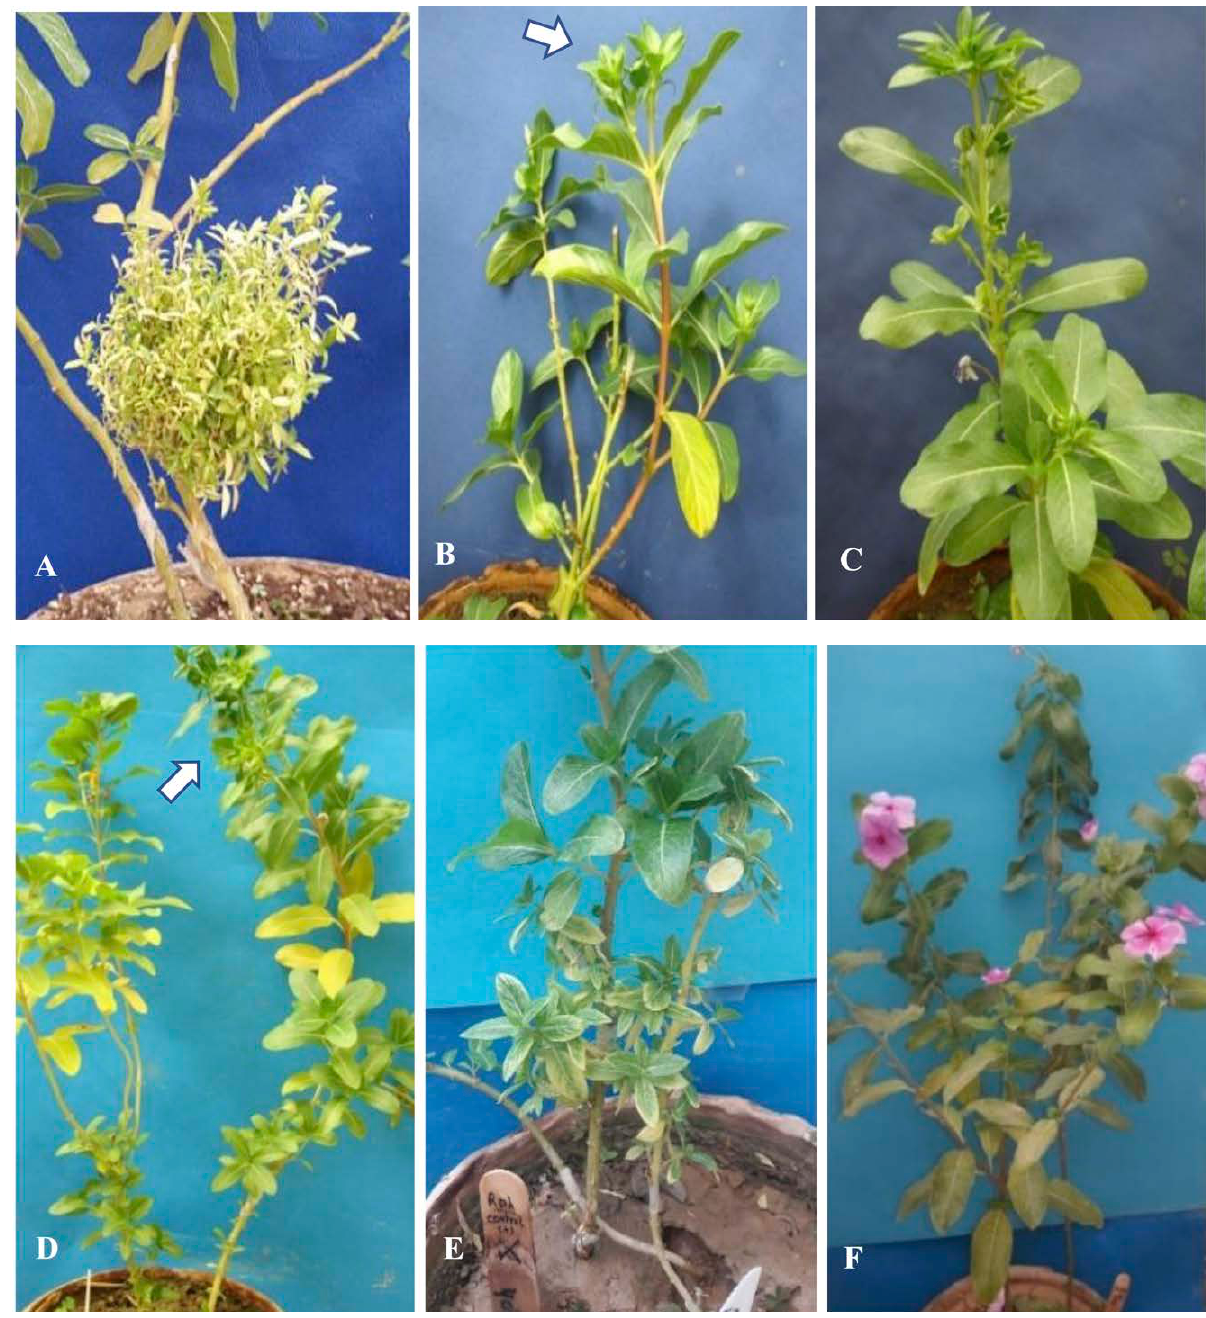
Figure 1. Disease symptoms in periwinkle plants following graft-inoculation with lime witches’ broom phytoplasma (LWBP), alfalfa witches’ broom phytoplasma (AWBP), tomato witches’ broom phytoplasma (TWBP), sesame phyllody phytoplasma (SPhP) and rapeseed phyllody phytoplasma (RPhP). (A) plants grafted with LWBP showing yellowing and severe symptoms of little leaf, shortened internodes, witches’ broom and stunting. (B-D) plants with yellowing, shortened internodes, virescence and phyllody due to AWBP (B), TWBP (C) and SPhP (D). (E) yellowing, shortened internodes, little leaf and stem proliferation due to RPhP. (F) healthy periwinkle plant. Arrows in B and D indicate flower phyllody and